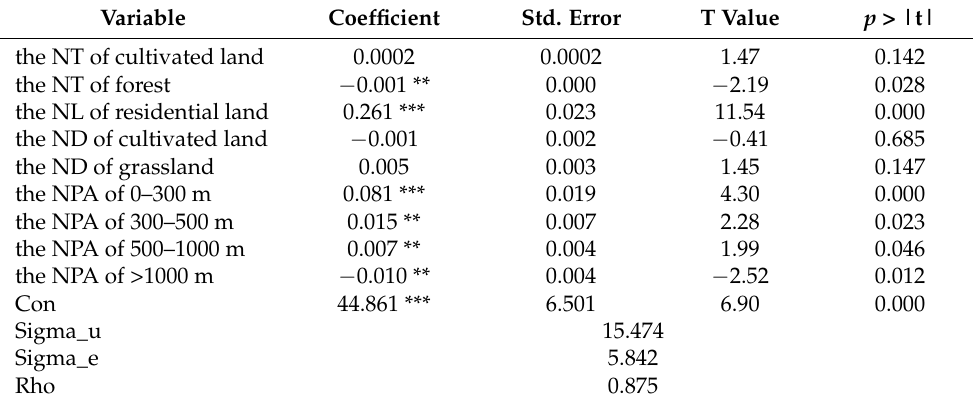
Table 3. Estimated coefficients for the random-effect model.